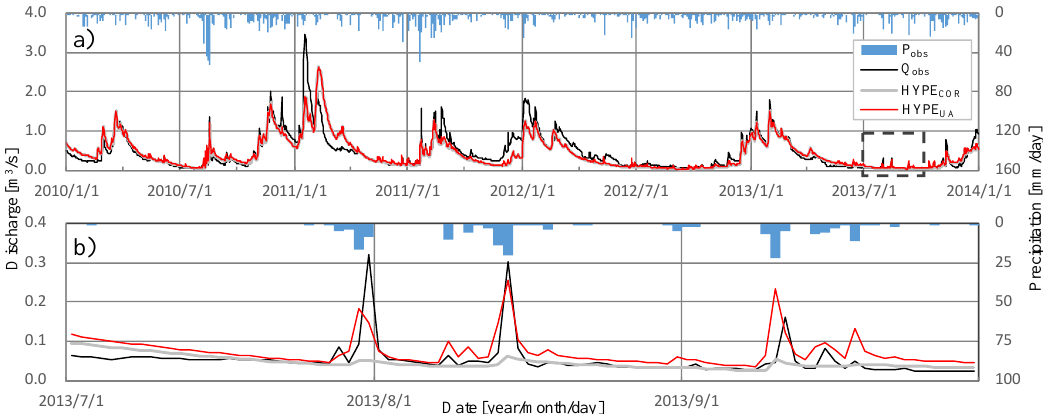
Figure 6. Time series of observed precipitation (P obs ), discharge (Q obs ) and discharge simulated by models HYPE COR and HYPE UA during periods 2010–2013 ( a ) and July–September 2013 ( b ). Table 3. Model performance calculated for the period from 1 January 2001 to 31 December 2013. The number of time steps included